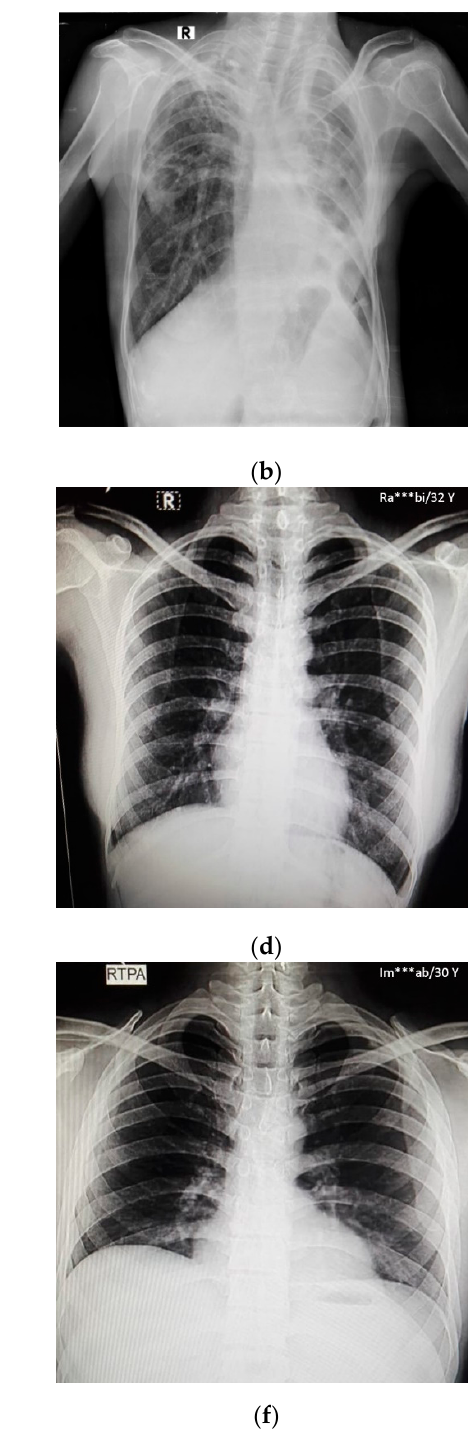
Figure 2. Samples of local Pakistani verified dataset used for the testing of trained models: ( a – c ) COVID-19 chest X-rays; ( d – f ) normal chest X-rays.